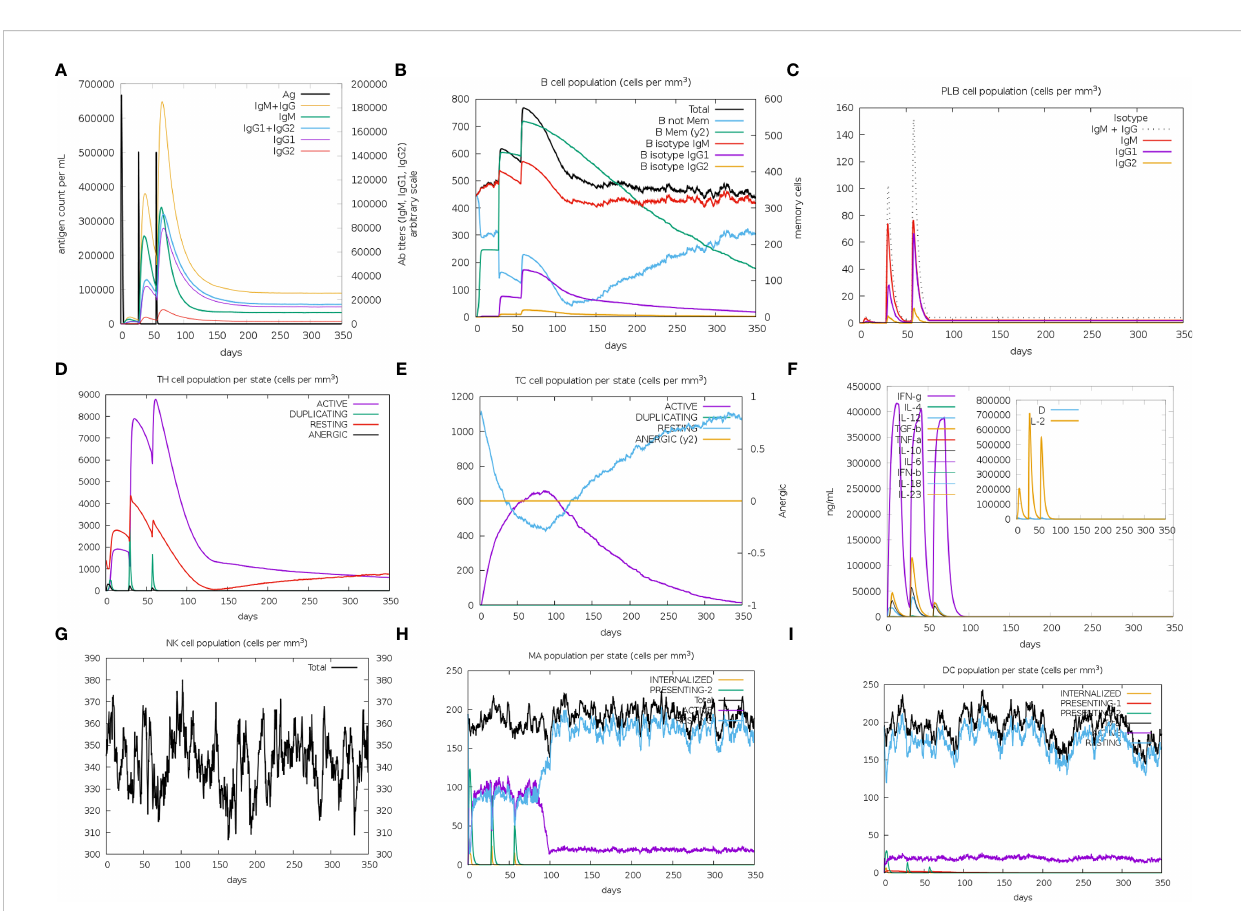
FIGURE 9 The plots relative to the immune stimulation of MPXV-5. (A) Titers of immunoglobulins and the immunocomplexes after vaccination. (B) Levels of B- cell population after vaccination. (C) Levels of plasma B-cell after vaccination. (D) Levels of helper T-cell cell population after vaccination. (E) Levels of cytotoxic T cells population after vaccination. (F) Concentration of cytokines and interleukins after vaccination. (G) Levels of NK cell population after vaccination. (H) Levels of MA population after vaccination. (I) Levels of DC population after